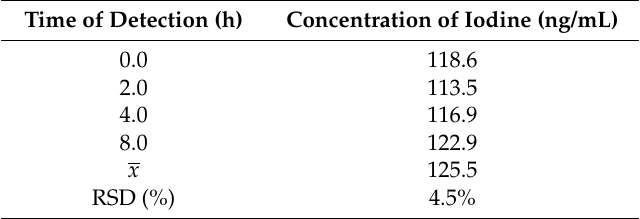
Table 5. Results of the stability experiment on